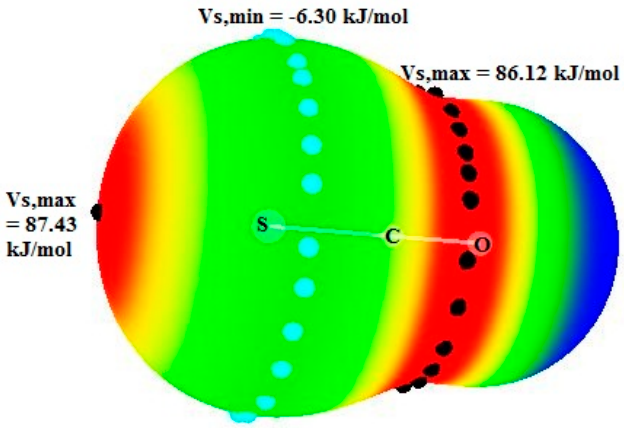
Figure 1. Electrostatic potential diagram of OCS molecule.